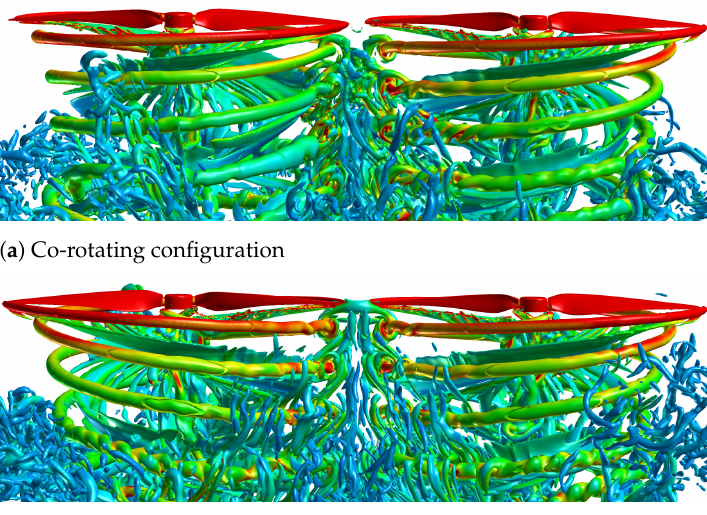
Figure 11. Instantaneous planar slice of vorticity magnitude along the centerline of the mesh system at the final time step for the dual rotor configuration with t = 0.04 D .